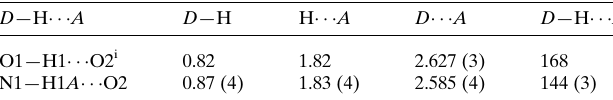
Table 1 Hydrogen-bond geometry (A˚ , (cid:2) ).